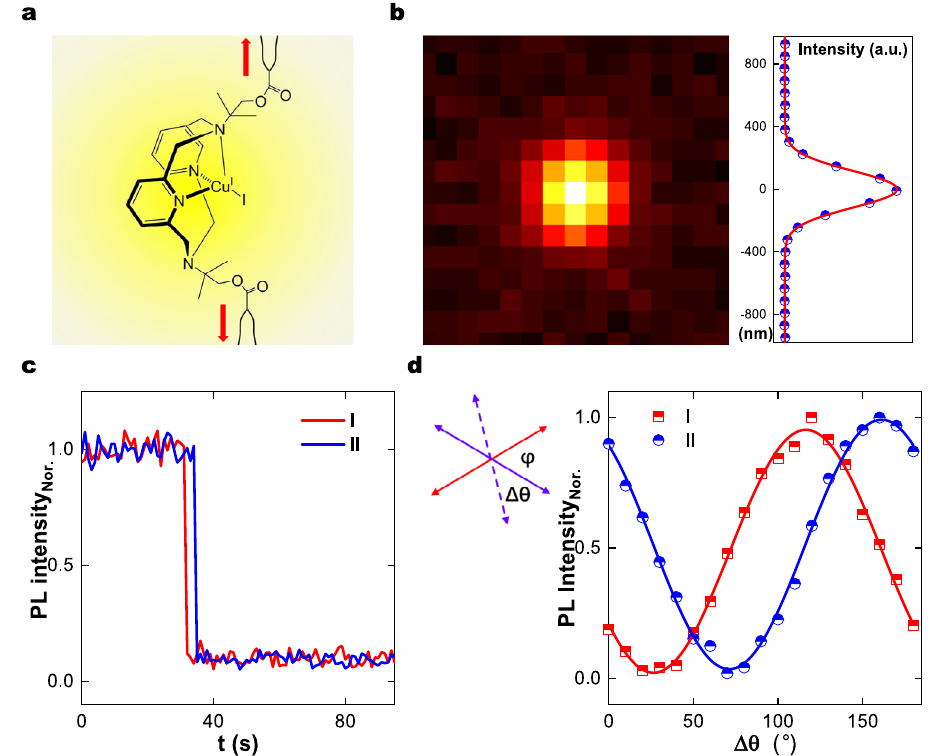
Fig. 1 | Evidence of single-molecule sensitivity from phosphorescent emission. a Chemical structure of the optical probe covalently attached to polymer strands. Mechanical force (red arrows) promotes brighter emission. Measurements in this fi gure are in a polymethacrylate (PMA) network stretched to λ =4. b Optical image with ratio ~1:1000 of phosphorescent to non-phosphorescent crosslinks shows a Gaussian intensity pro fi le with full-width-at-half maximum FWHM=280nm, close to the diffraction limit. c Photoluminescence (PL) plotted against time for two molecules (I and II) shows single-step photobleaching under excessively strong